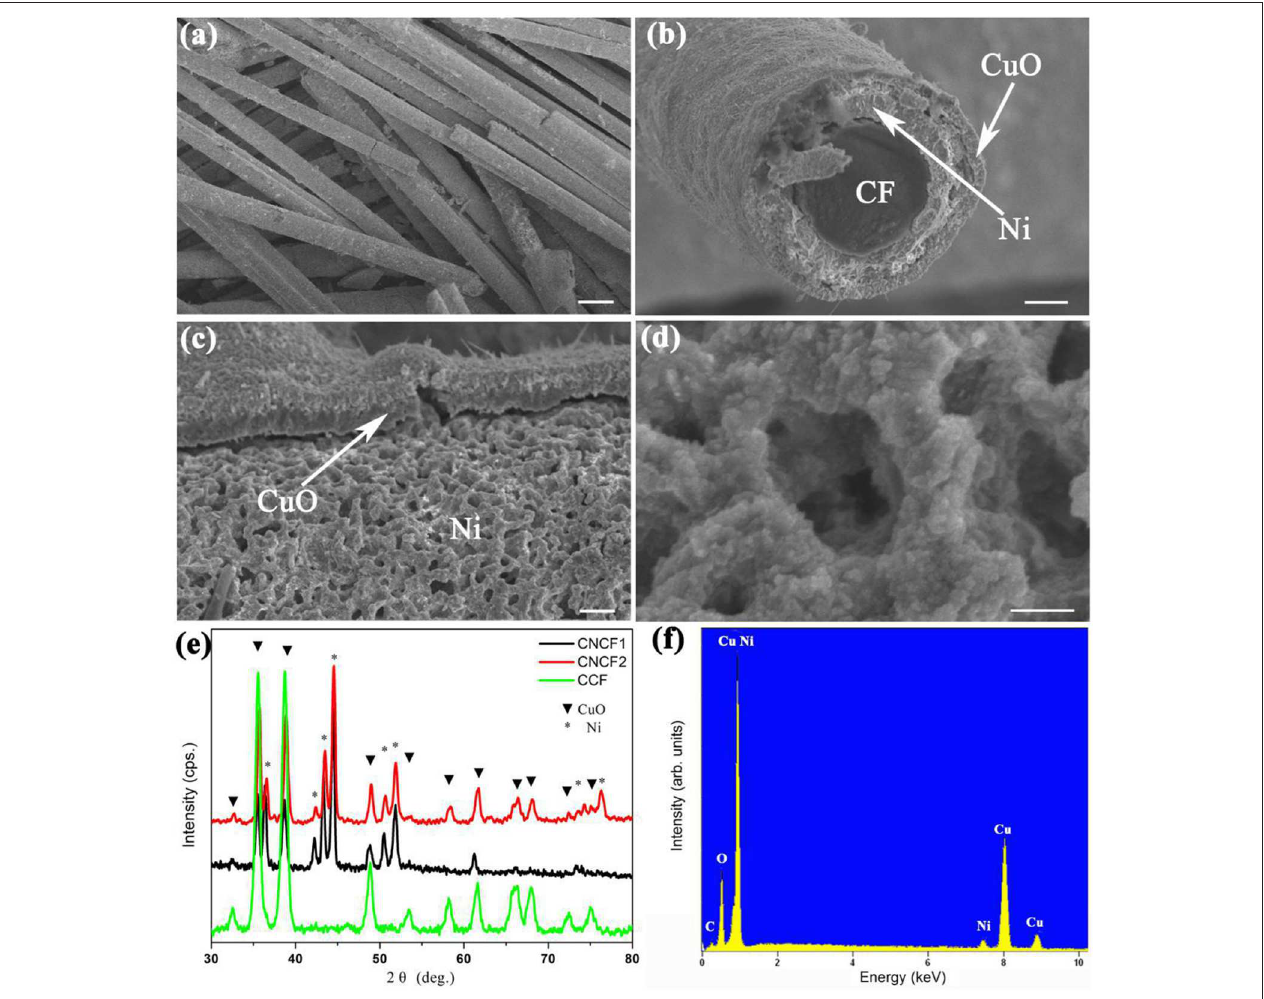
FIGURE 1 | The FESEM images at different magnifications, EDS patterns, and XRD patterns of CNCF composites: (a) low magnification FESEM image, (b) end plane magnification image, and (c) low and (d) high magnification FESEM images of the section plane; (e) XRD and (f)